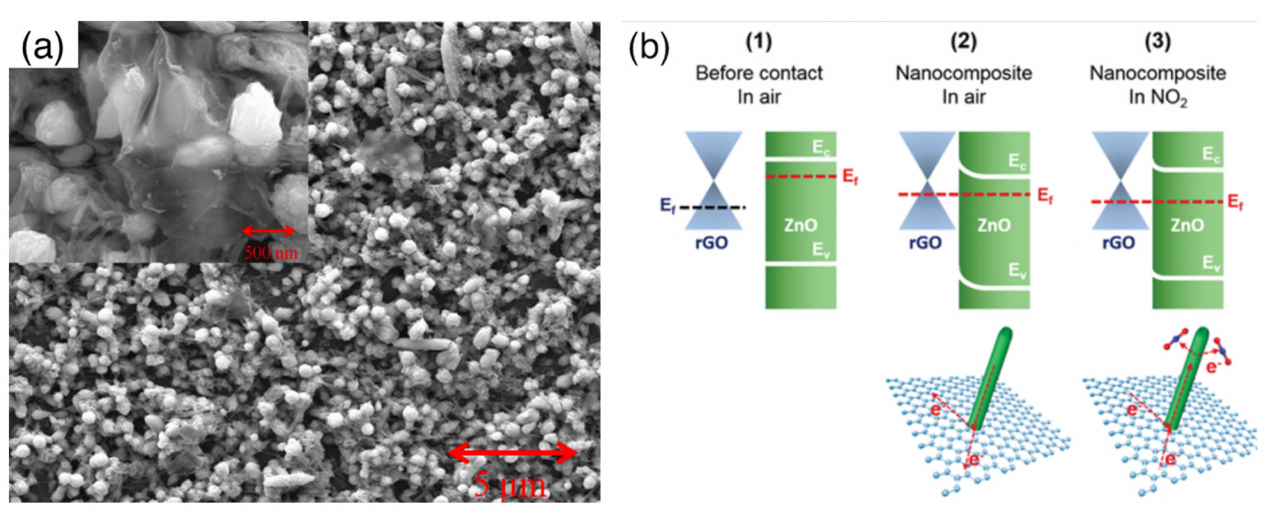
Figure 9. RGO–MOX interface. SEM image (top view) of the RGO–ZnO nanorods composite ( a ). Schematic representation of the electrical coupling mechanism between RGO and ZnO nanorods; energy bands are shown for the following three situations: disjointed materials, coupled materials exposed to air, and to NO 2 ( b ). Figure 9a is reprinted from [169], Copyright (2018) with permis- sion from Elsevier. Figure 9b is reprinted with permission from [159], Copyright 2016 American Chemical